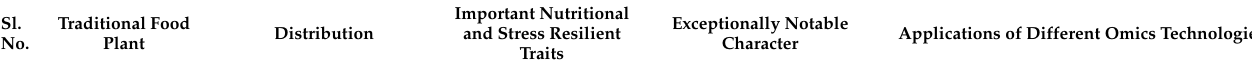
Table 2. Overview of use of omics tools to identify genes/proteins/ions regulating important traits in traditional food plants. Sl.